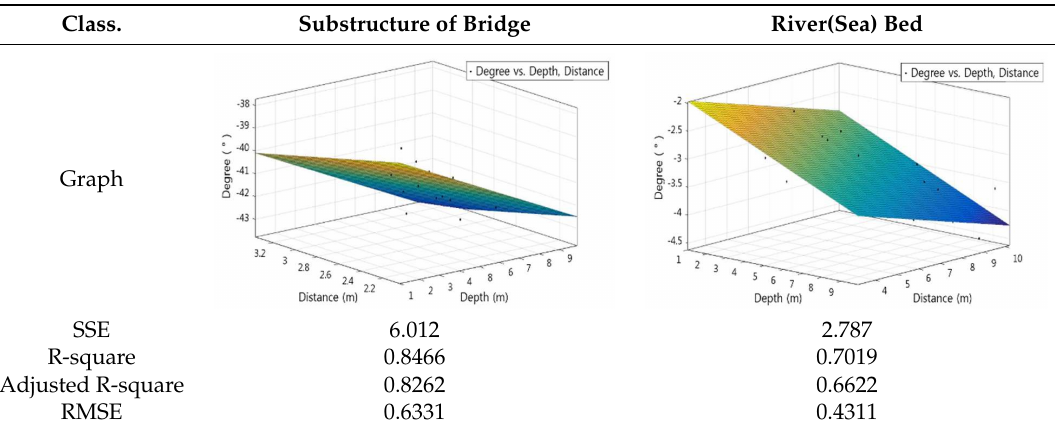
Table 3. Result of multi-linear regression.